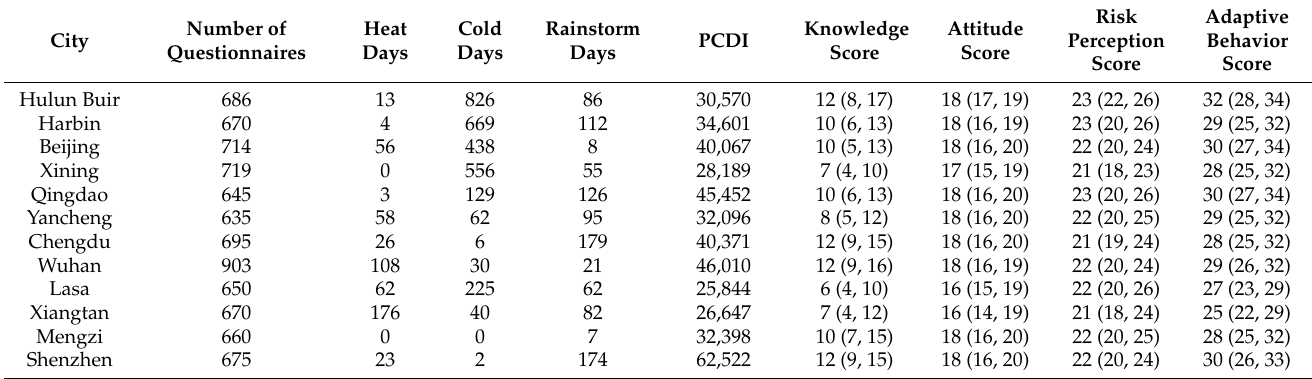
Table 2. Weather conditions and scores in each city.